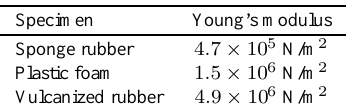
Table 1 Young’s moduli of sample